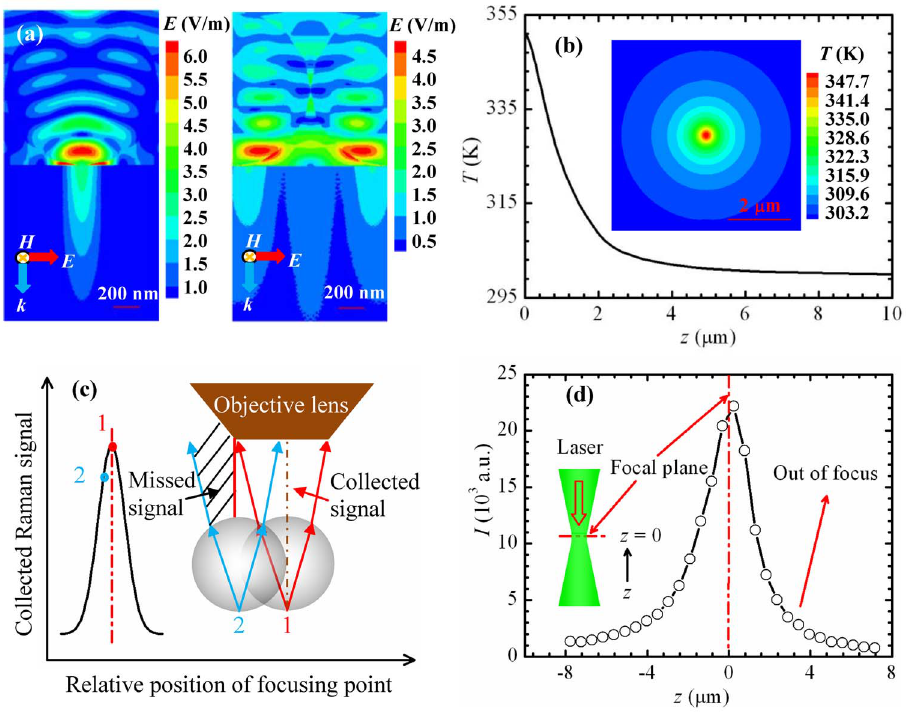
Figure 6. Modeling results and difference illustration. (a) HFSS modeling of a plane wave passing through a 1.21 m m silica sphere ( e =2.13 + 0 i ) in air above a silicon substrate ( e =17.22 + 0.428 i ). The amplitude of electric field is equal to the enhancement factor. In the left figure, the particle center is under the laser spot center. In the right figure, the particle center is at the fringe of the laser spot area. (b) Temperature profile inside a silicon substrate beneath a 1210-nm silica particle under laser irradiation. The inset shows the temperature distribution on the top of the substrate. (c) How the collected Raman signal varies with distance between the center of objective lens and laser focusing point in silicon. Position 1 represents the coincidence of the focusing point and the lens center, and position 2 shows a distance between them. (d) The variation of silicon Raman intensity with the laser focal level in the vertical direction.